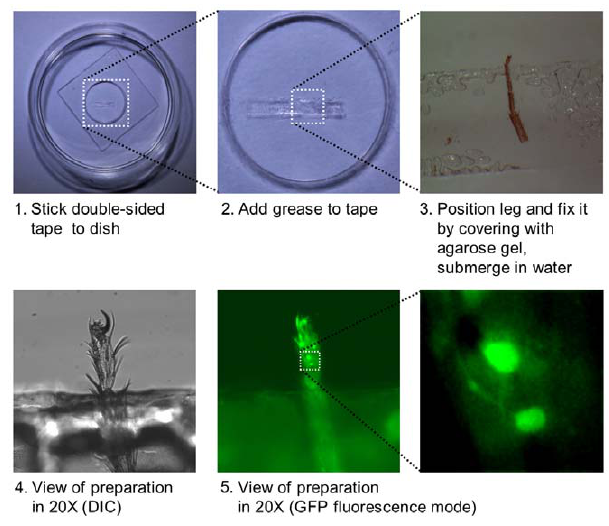
Figure 1. Preparation of forelegs for Ca 2 + imaging of tarsal GRNs. A double-sided scotch tape is stuck to a 35 mm glass bottom dish (1). A drop of silicon oil is applied on top of the tape (2) and the foreleg, cut between the femur and the tibia, is fixed to the tape, such that the tibia and the upper tarsal segments are covered with oil, while the 4 th and part of the 5 th tarsal segment are exposed (3). (4) shows a DIC view of the preparation using a 20 6 objective and the same preparation is shown in (5) and further magnified in using live GFP fluorescence. The two taste neurons expressing G-CaMP3.0 under the control of Gr61a-GAL4 can be seen. max D F/F %, measurements were taken in the cell bodies or at the base of axons. Adjacent regions were used to determine background auto fluorescence. Average of five frames taken immediately before the application of ligand was defined as a baseline. Max D F/F % represented the highest value within 30 seconds after ligand application. For most but the lowest concentrations tested, max D F/F was reached between 1 and 3 seconds after ligand application, whereas for the lowest concentrations tested, max D F/F was reached between 20 and 30 seconds after application.